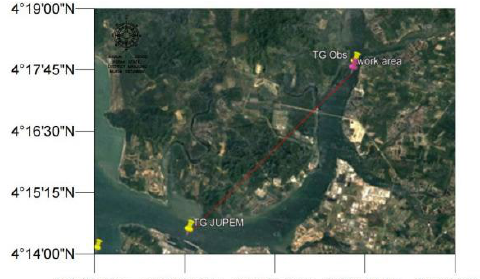
Figure 1. A study area at Sungai Dinding, Lumut (Google Earth, 2022) Table 1. The coordinates and data period of the DSMM tide gauge station (Hao, 2021)